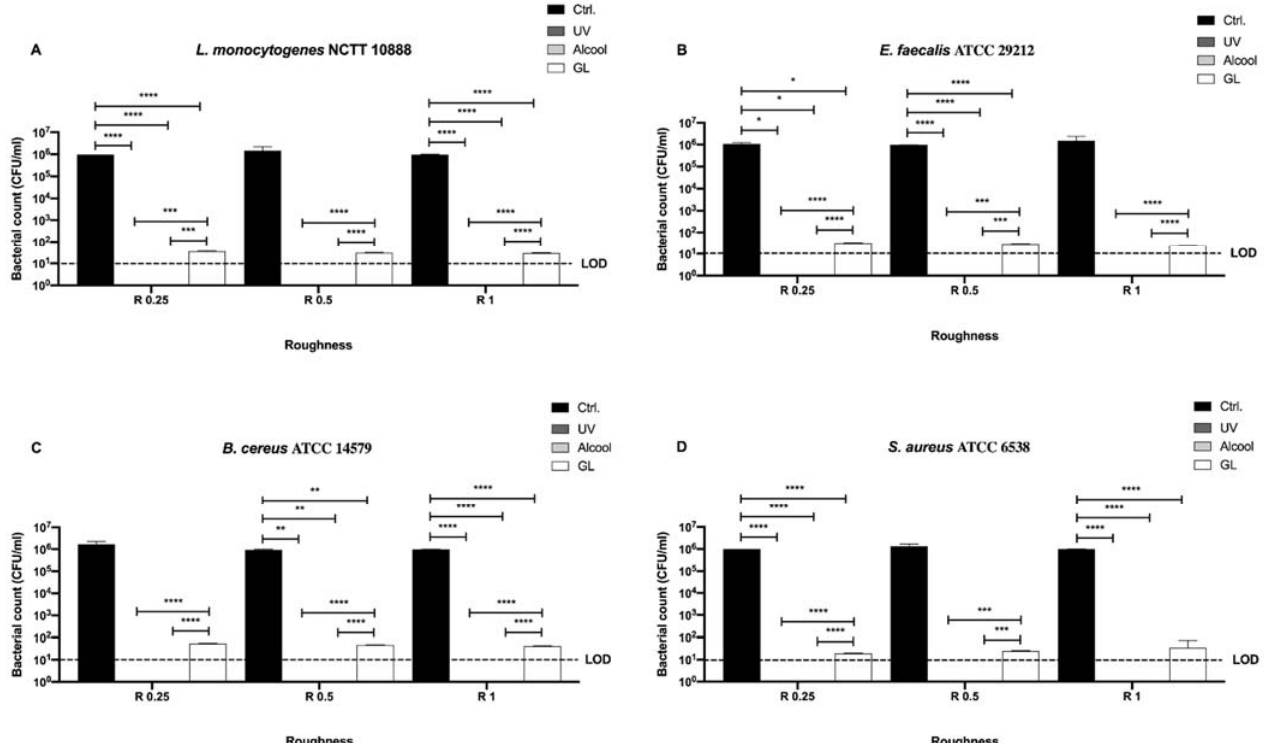
Figure 3. Graphical representation of the antibacterial activity of UV, alcohol 70% v/v and GL against Gram-positive bacteria ( A – D ) at different AISI 316 stainless steel surface roughness, **** p < 0.0001, *** p < 0.001, ** p < 0.01, * p < 0.05; Limit of detection (LOD) is 10 1 (10E+1).